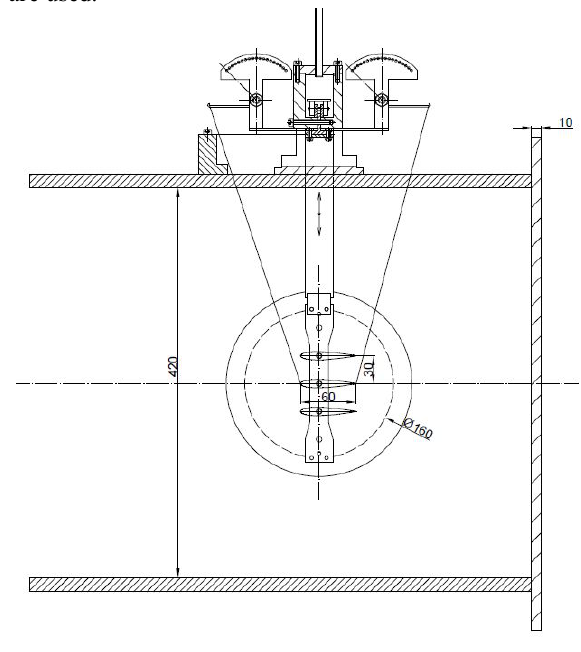
Fig. 9. The schema of the elastic members of the profile rotation, located outside the test section